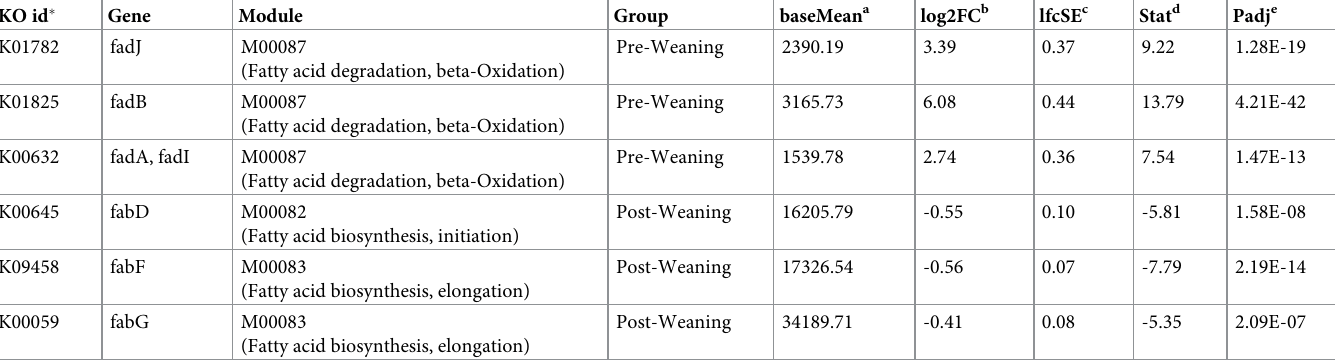
Table 1. List of predicted genes involved in lipid metabolism differentially enriched in fecal bacterial community of weaned piglets (Post-Weaning) and suckling piglets